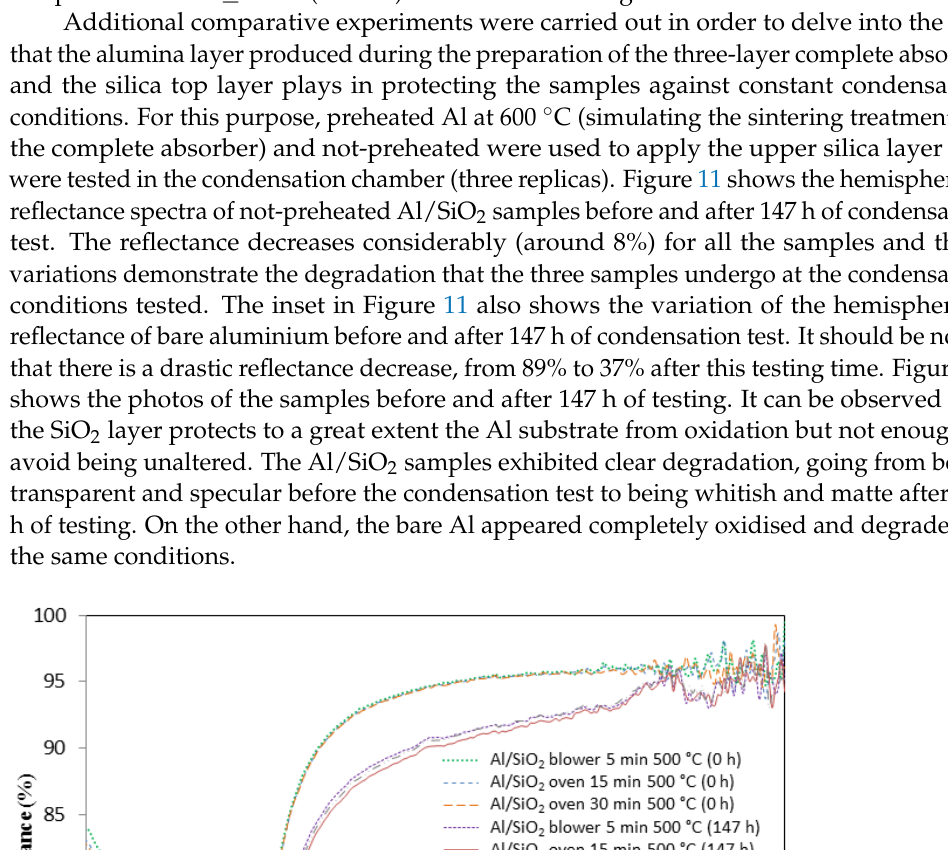
Figure 12. Photographs of bare Al and Al/SiO 2 samples before and after 147 h of condensation test. The hemispherical reflectance spectra of Al/SiO 2 preheated before applying the silica layer together with bare aluminium preheated and heated (simulating the sintering treatment of the SiO 2 layer) are plotted in Figure 13. The preheating treatment of the